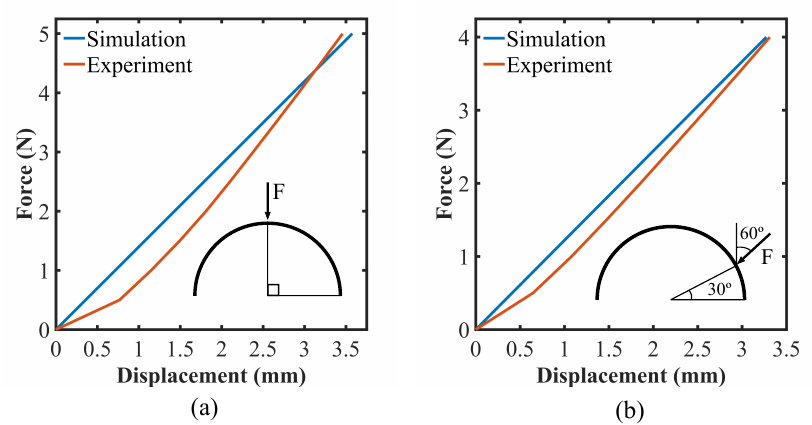
Figure 13. Deformation of the sensor for the applied forces ( a ) At 90 ◦ latitude and ( b ) At 30 ◦ latitude on one of the flex